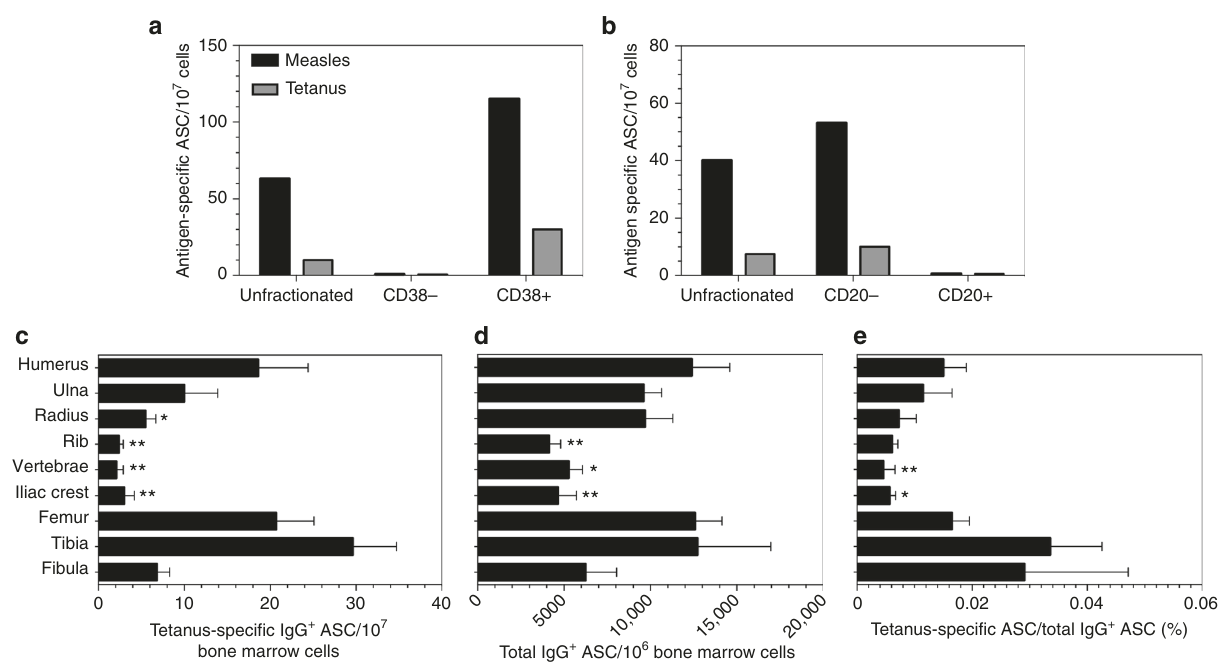
Fig. 3 Antigen-speci fi c and total IgG + plasma cells in different bone marrow compartments. Quantitation of tetanus-speci fi c, measles-speci fi c, or total IgG- speci fi c antibody-secreting cells (ASC) was determined directly ex vivo in 6-hour ELISPOT assays. a , b Samples of femoral bone marrow cells from a representative animal (Rh#21128) were assayed to determine the frequency of measles-speci fi c and tetanus-speci fi c ASC by ELISPOT from unfractionated bone marrow compared to the frequencies observed after MACS-based separation of a CD38 − vs. CD38 + cell populations or b CD20 − vs. CD20 + cell populations. The frequency of tetanus-speci fi c ASC c , the frequency of total IgG-secreting ASC d and the frequency of tetanus-speci fi c ASC as a percentage of total IgG-secreting ASC e was determined by ELISPOT analysis for each of the indicated bone marrow sites. The bars in c – e represent the mean ± S.E.M. Signi fi cant differences in plasma cell frequencies between the indicated bone marrow sites compared to the femur are indicated by Dunnett adjusted P values ( c , d ; mixed effect negative binomial regression, e ; rank based mixed effect linear regression , n = 6, see also Supplementary Fig. 2). Symbols, * P < 0.05 and ** P < (30, 21, and 19 ASC/10 7 cells, respectively) with little or no difference in tetanus-speci fi c plasma cell frequencies among B cell-depleted experimental animals vs. untreated controls (Sup- plementary Fig. 2) as expected based on serum antibody levels (Figs. 1 and 2). The ELISPOT data from all 6 animals was averaged (Fig. 3) and when compared to the femur, there were signi fi cantly fewer tetanus-speci fi c plasma cells identi fi ed in the radius, rib, vertebrate, or iliac crest (5.5, 2.4, 2.1, and 3.0 ASC/10 7 cells, respectively; P < 0.05, mixed effect negative binomial regression, Dunnett adjusted). We also found a non-signi fi cant trend towards lower numbers of tetanus-speci fi c plasma cells in the fi bula (6.8 ASC/10 7 cells) and ulna (10.0 ASC/10 7 cells) compared to femur (Fig. 3c). One explanation for the reduced